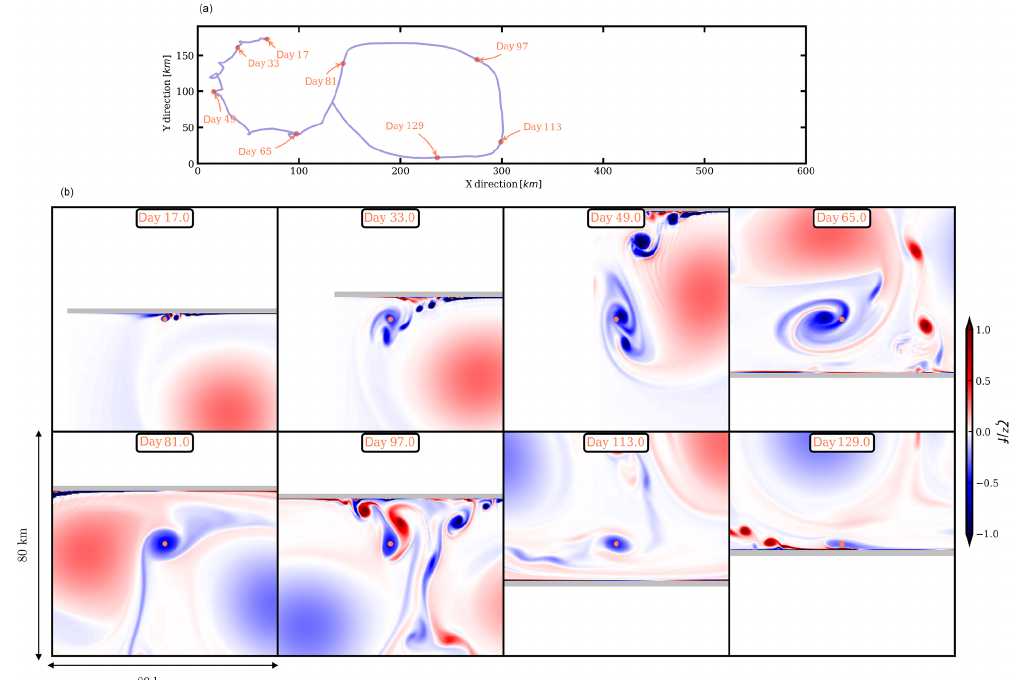
Figure 9. (a) Pathway of a submesoscale anticyclone originating from the bottom boundary layer. (b) Major events from the birth to the death of the small